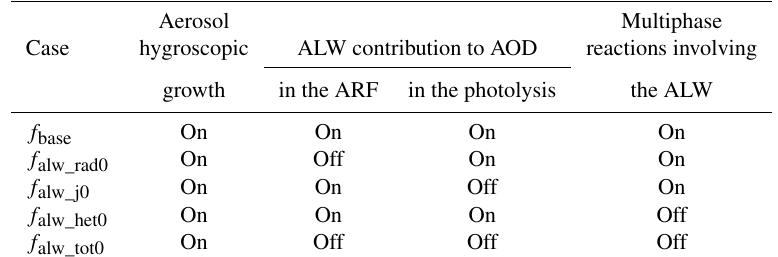
Table 2. Description of the sensitivity simulations.